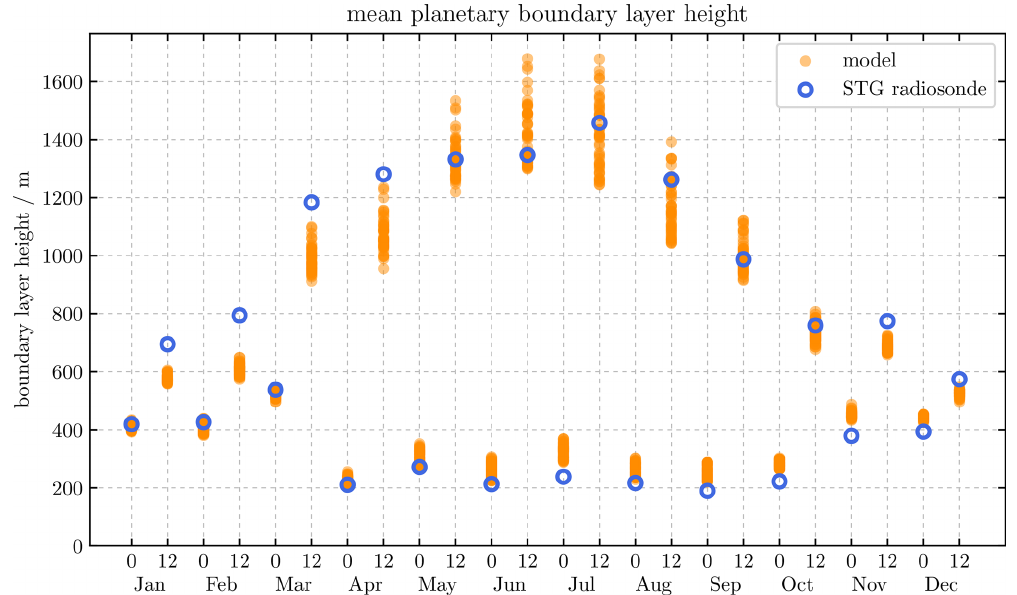
Figure 8. Monthly mean boundary-layer height at 00:00 and 12:00LT for different land covers diagnosed from radiosonde observations at STG and from atmospheric profiles above grid boxes of